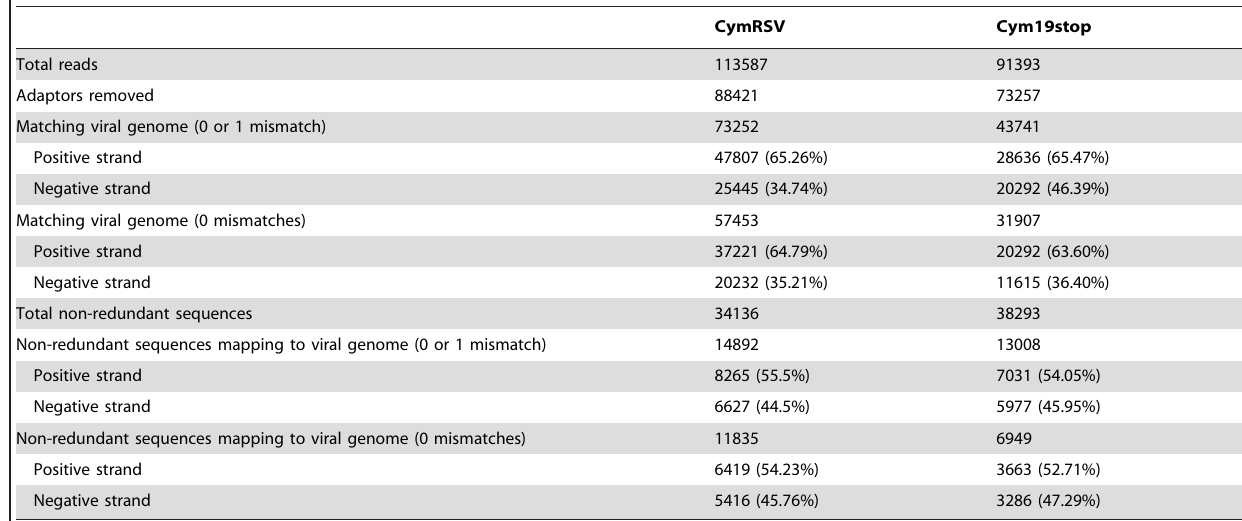
Table 1. Summary of 454